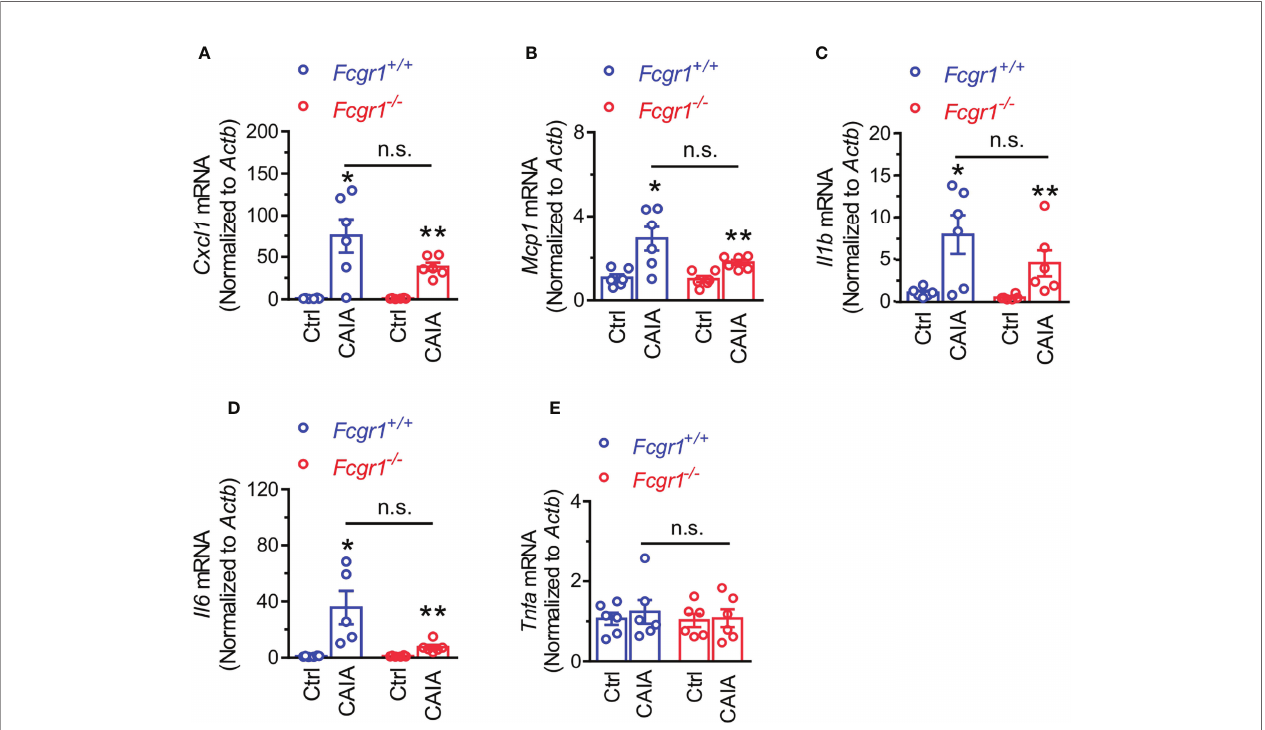
FIGURE 8 | Genetic deletion of Fcgr1 does not affect the upregulation of mRNA expression of proin fl ammatory mediators in the DRG after resolution of in fl ammation in the CAIA model. (A – E) qPCR analysis of the mRNA expression (normalized to that of Actb ) of Cxcl1 (A) , Mcp1 (B) , Il1b (C) , Il6 (D) , and Tnfa (E) in the DRG of Fcgr1 +/+ and Fcgr1 -/- mice on day 56 after immunization. n = 5-6 mice/group; *p < 0.05, **p < 0.01 versus control (Ctrl); two-way ANOVA followed by Bonferroni post hoc test. n.s., not signi fi